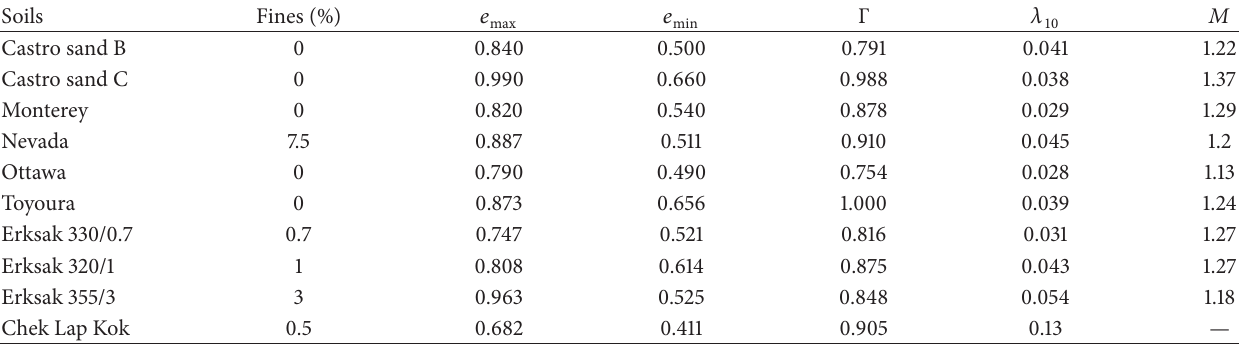
Table 3: Critical state properties of some soils (after Jefferies and Been [5]).